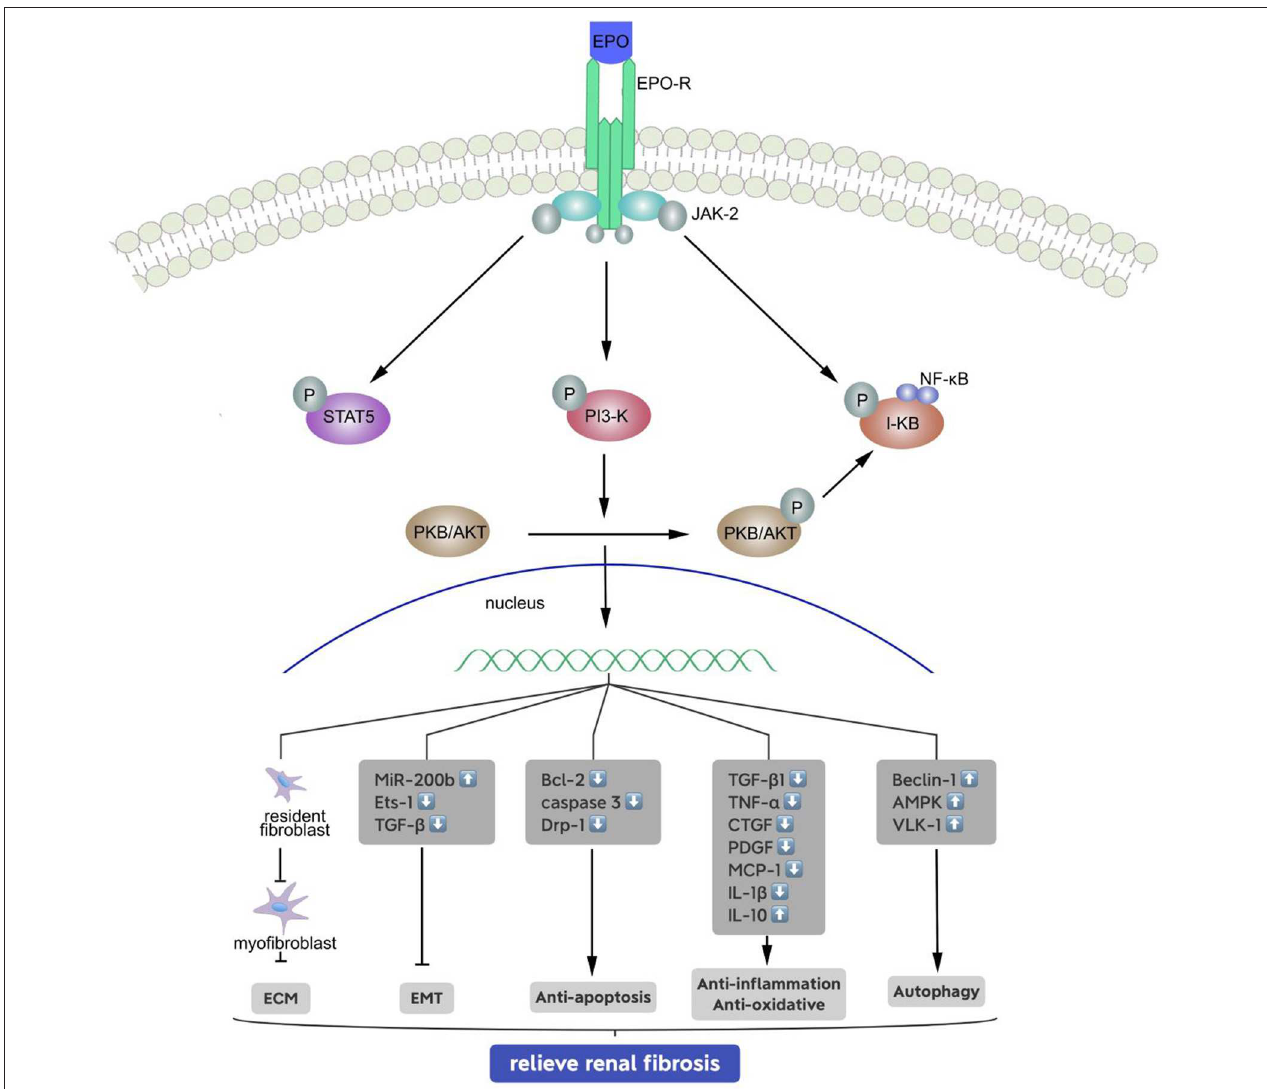
FIGURE 1 | Signal transduction pathways of the erythropoietin receptor and mechanisms of relieving renal fibrosis. Binding of erythropoietin (EPO) causes conformational changes to the EPO receptor, phosphorylation of associated JAK-2, PI-3 kinase and I-kB molecules, and activation of signaling molecules and target genes: (1) inhibits the generation of stromal mesenchymal fibroblasts; (2) inhibits the EMT by upregulating miR-200b, and reducing of Ets-1 and TGF- β ; (3) phosphorylates and inactivates proapoptotic molecules; (4) reduces inflammation by inhibiting the release of pro-inflammatory cytokines and anti-oxidative, and (5) enhances autophagy to some